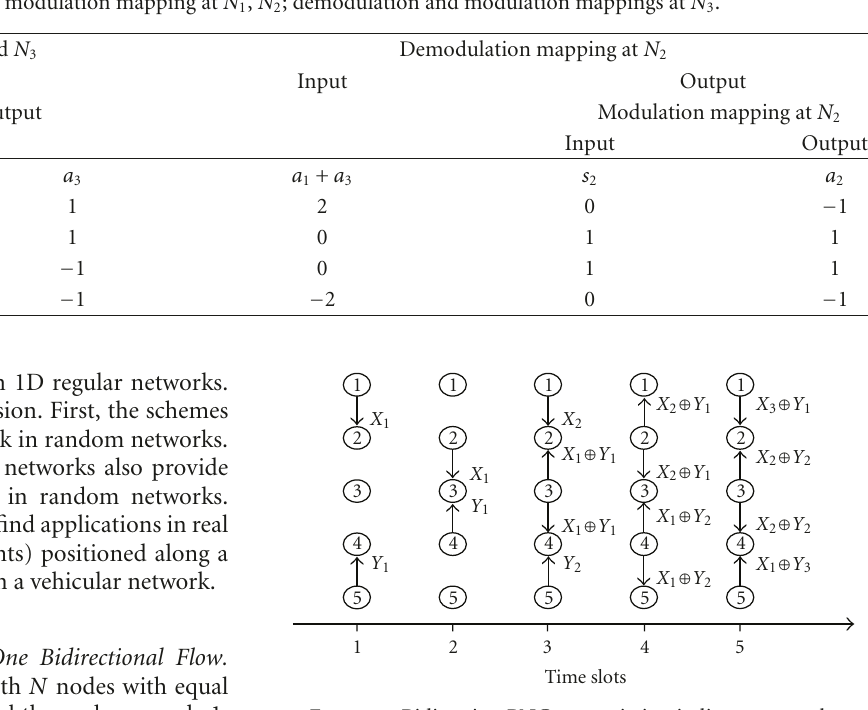
Figure 5: Bidirection PNC transmission in linear